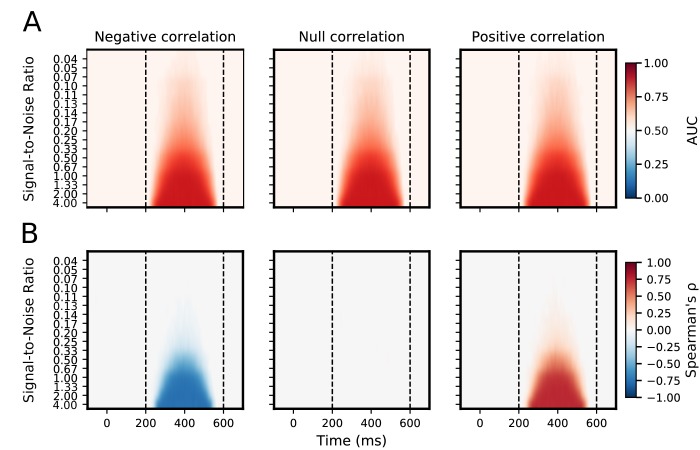
Results of location decoding and correlation analysis of a simulated dataset across several signal-to-noise ratios (SNRs).We simulated ERPs for targets at all four target positions. These artificial ERPs were either positively, negatively, or not correlated between vertical and horizontal target position. The SNR of the simulated dataset was then manipulated by adding random noise of various levels (relative to the peak amplitude of the ERP) to the data. (A) AUC scores (color coded) are shown for a location decoding analysis, separately for the injected correlation and SNR across time. (B) Spearman’s ρ correlation (color coded) between confidence scores of the vertical and horizontal classifiers, separately for the injected correlation and SNR across time. For both A and B, only those time points were colored that survived cluster-based permutation testing (α = 0.05, 5000 permutations). Dashed vertical lines indicate the time window in which the ERP was injected. The figure shows that both location decoding and the retrieving of the injected correlation declined with decreasing SNR. Importantly, reliable correlations disappear before classification itself, indicating that for the average group classification levels as observed in our data, any correlation present may have been too low to be detected.